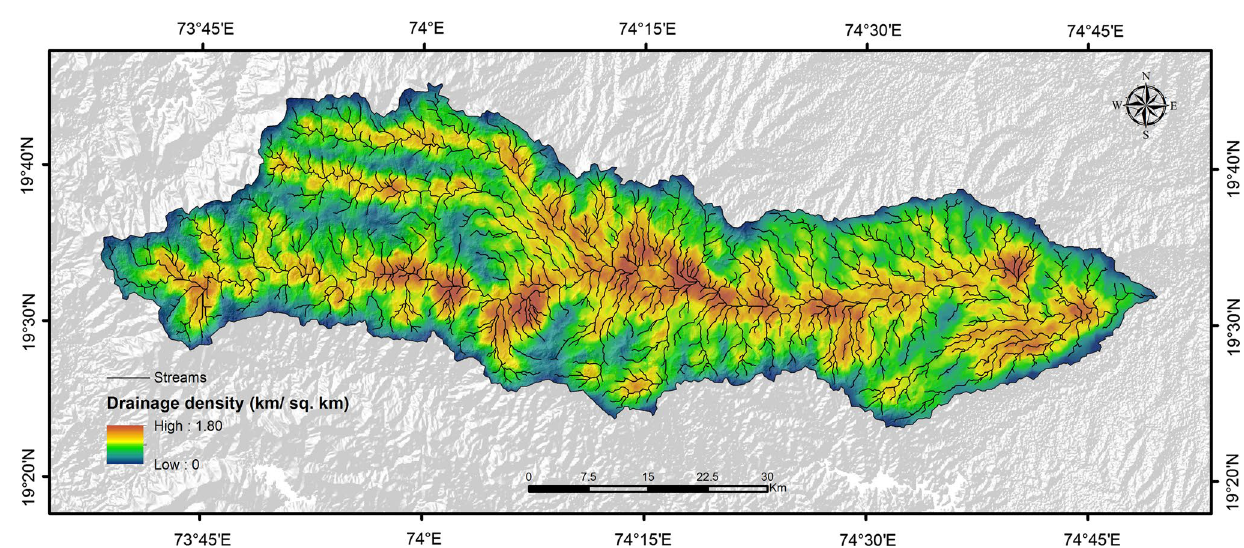
Fig. 8 Drainage density map of the study